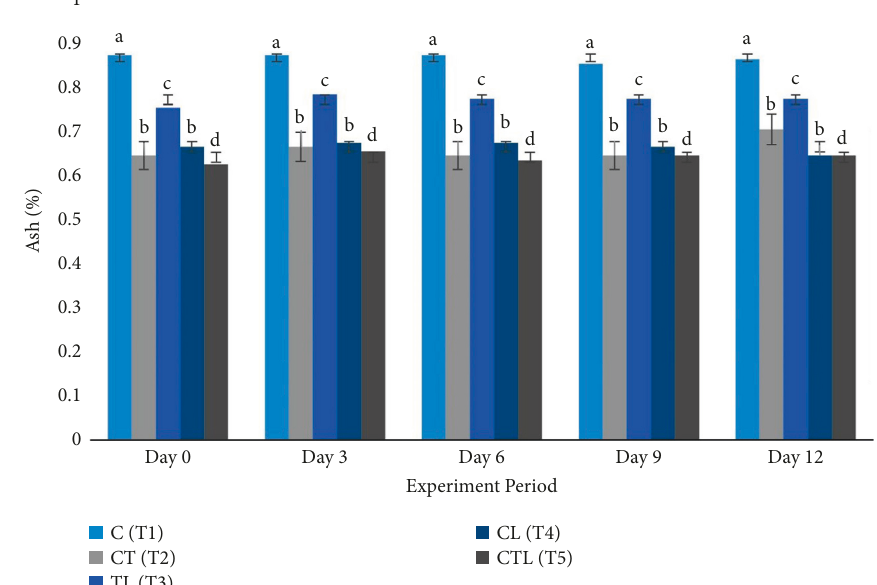
Figure 2: Percentage of ash content in the carp fillet immersed in mixed different extracts of turmeric, cinnamon, and lemon at 4 ° C.